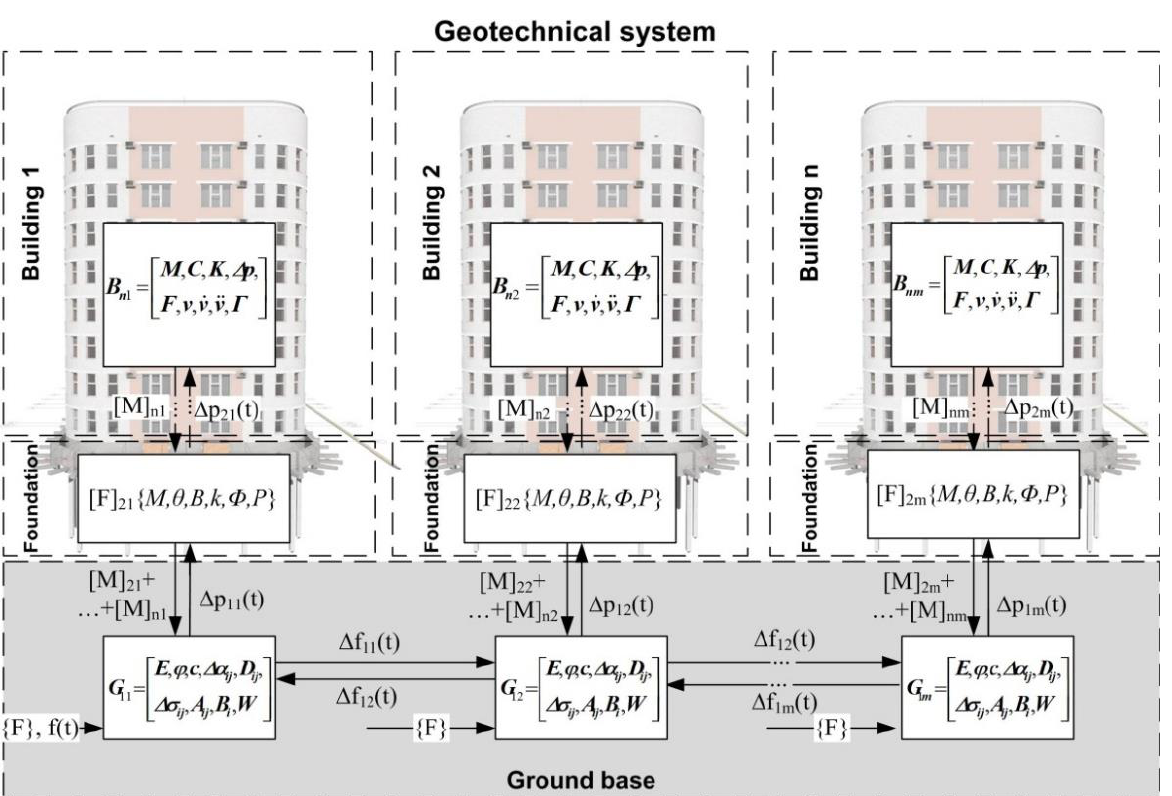
Figure 1. A model of a geotechnical system.